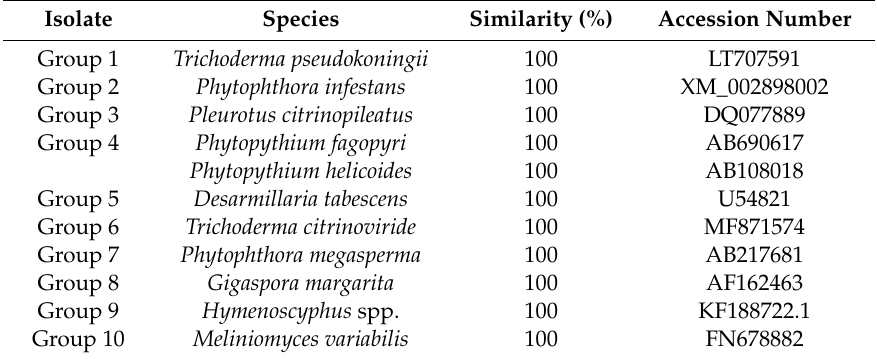
Table 1. Identification of fungal isolates based on ITS1-5.8S-ITS2 region analysis. One isolate per uniform morphological group was identified.